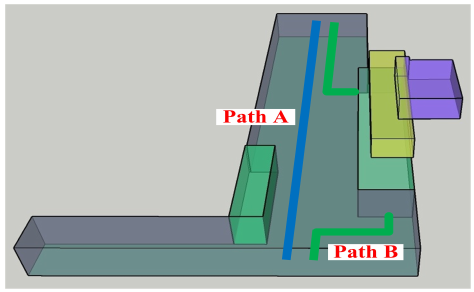
Figure 12. Top-bounded spaces creation in Rhino.